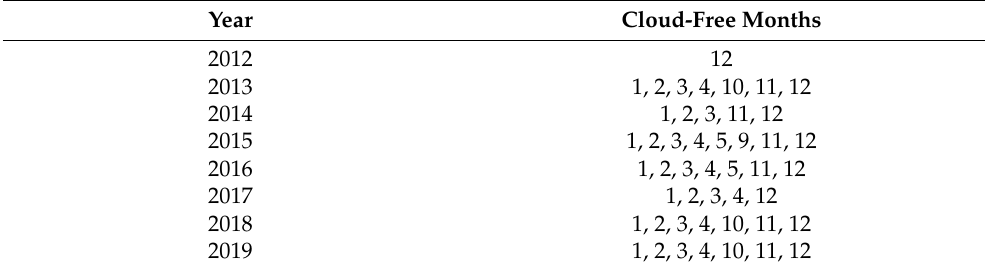
Table 2. Cloud-free months in night-light images of Cambodia, 2012–2019.